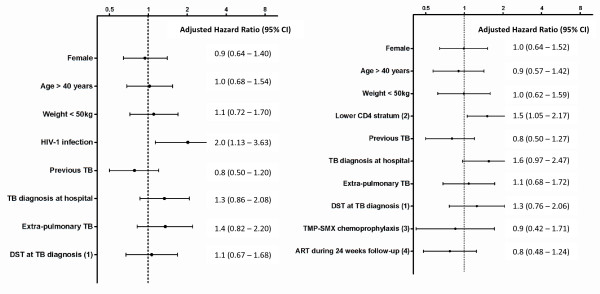
a: Hazard ratios (95% CI) of risk factors for clinical deterioration during 24 weeks of antituberculosis (TB) treatment in 292 patients (Cox proportional hazards model) and Figure 2b>: Hazard ratios (95% CI) of risk factors for clinical deterioration during 24 weeks of TB treatment in 206 HIV-1 infected patients* (Cox proportional hazards model). *CD4 count not performed in 3 of 209 HIV-1 infected patients (1) Microbiologic confirmation with drug susceptibilities known at TB diagnosis  (2) CD4 strata used: Stratum 1 = CD4+ > 350 cells/ μL, stratum 2 = CD4+ from 200 – 350 cells/ μL,  stratum 3 = CD4+ < 200 cells/ μL;  (3) TMP-SMX chemoprophylaxis = Trimethoprim sulfamethoxazole 160/800mg daily  (4) Antiretroviral treatment regimens as follows: D4T/3TC/EFV (89), D4T/3TC/NVP (3),  AZT/3TC/EFV (13), AZT/3TC/NVP (2), TDF/3TC EFV (2); D4T= stavudine 30mg twice daily,  3TC = lamivudine 150mg twice daily, EFV = efavirenz 600mg nocte, AZT = zidovudine 300mg  twice daily, NVP = nevirapine 200mg twice daily, TDF = tenofovir 300mg daily  TB = tuberculosis, DST = drug susceptibility testing, ART = antiretroviral treatment, P = p-value  (significant if < 0.05), 95% CI = 95% confidence interval